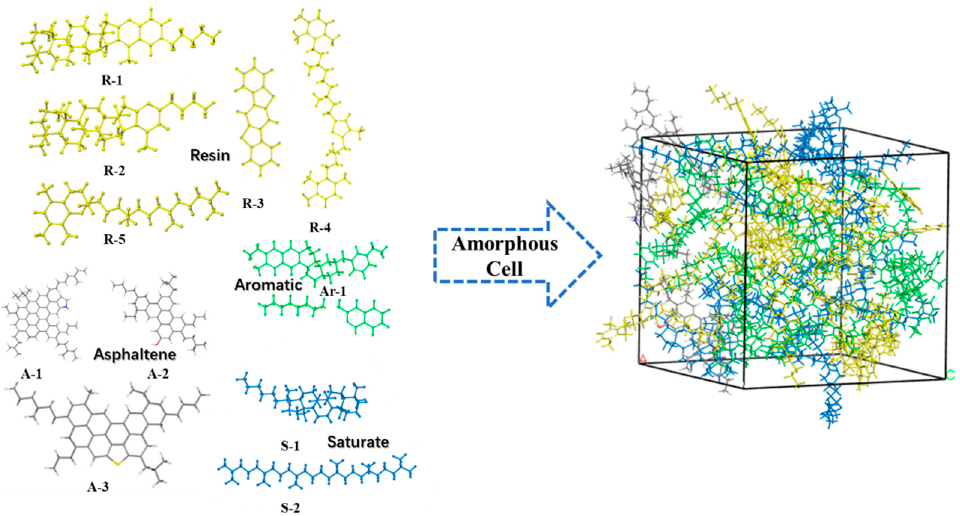
Figure 3. Matrix asphalt model composition.